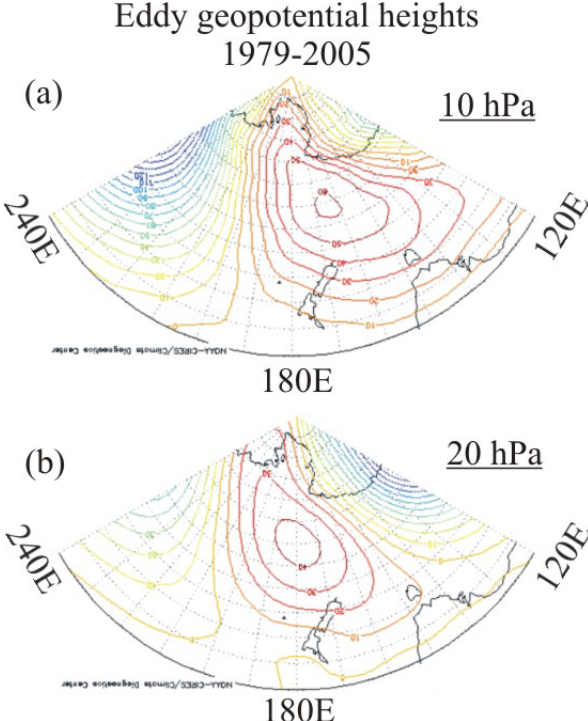
Fig. 8. (a) and (b) Eddy geopotential heights within the sector 120 ◦ E–240 ◦ E at the pressure levels 10hPa and 20hPa, respec- tively, NCEP-NCAR reanalysis